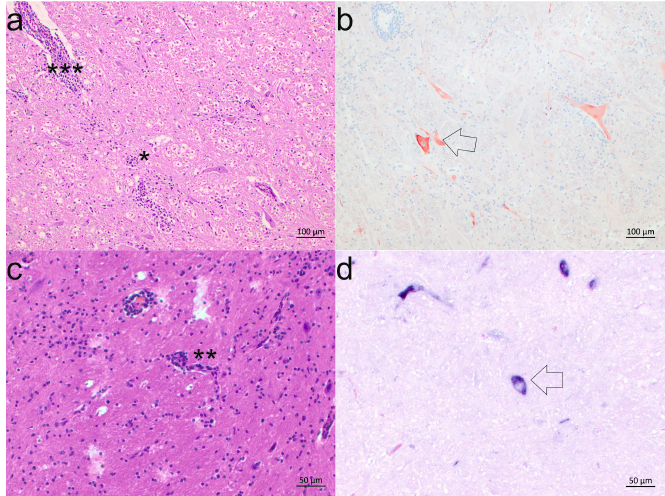
Figure 3. Comparison of the detection of the viral RNA (vRNA) by in situ hybridization (ISH) and of the viral proteins by immunohistochemistry (IHC). The vast majority of analyzed sections show a good correlation of ISH and IHC, with a comparable staining in neurons, as seen in the cerebrum of case 50898 ( a , b ; examples are indicated by arrows). Only in three sections can a lack of correlation be observed, with either a negative ISH-result ( c ), or a red, granular staining in the IHC ( d , arrow) as seen in the brainstem of case 50898, or vice versa, in case 25018: a deep purple ISH staining in neurons of the brainstem ( e , arrows) is observed, while the IHC remains negative ( f ).